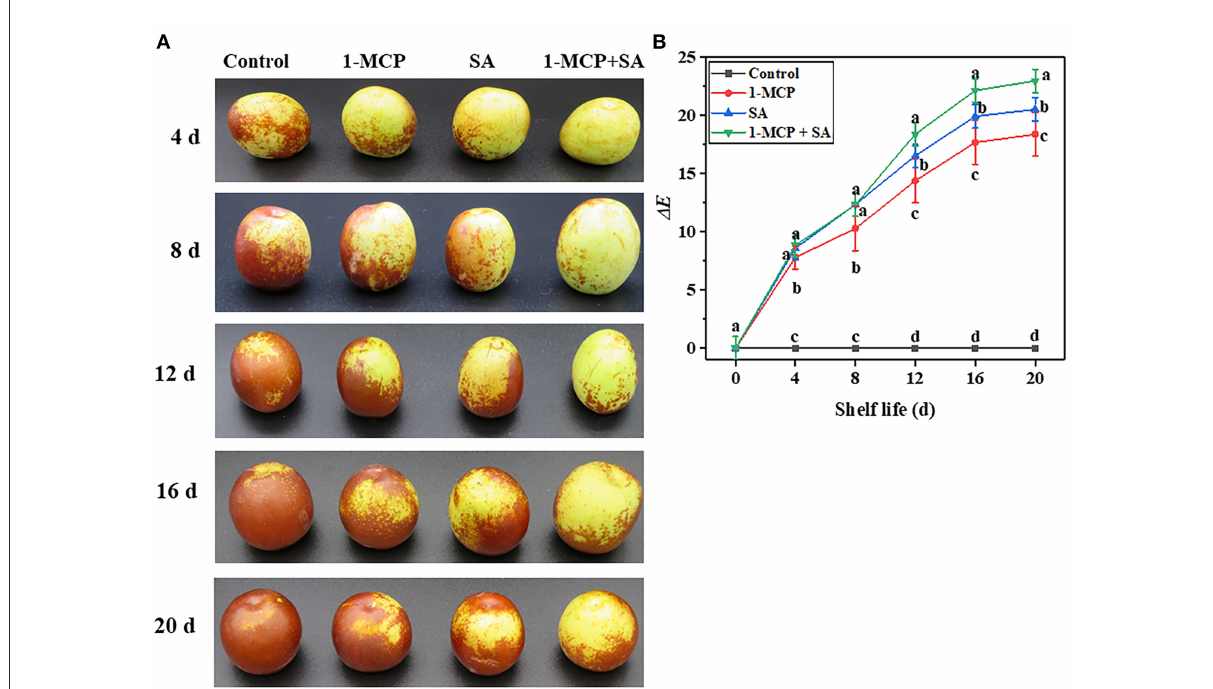
FIGURE2 Effects of 1-methylcyclopropene (1-MCP), salicylic acid (SA), and 1-MCP and SA combined treatments on fruit appearance (A) and color value 1 E (B) of winter jujube during shelf life at 4 ± 1 ◦ C for 20 d. The data presented are the mean values of three replicates; Vertical bars represent the standard errors of mean values; values followed by different superscripts (a–d) are significantly different ( P < 0.05) on the same sampling